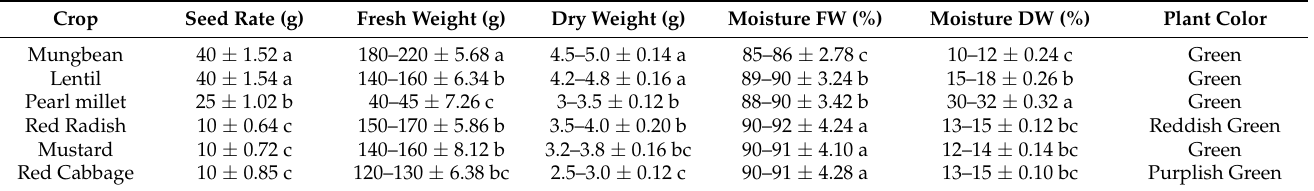
Table 6. Seed rate and yield attributes of different microgreens grown under a controlled environment.